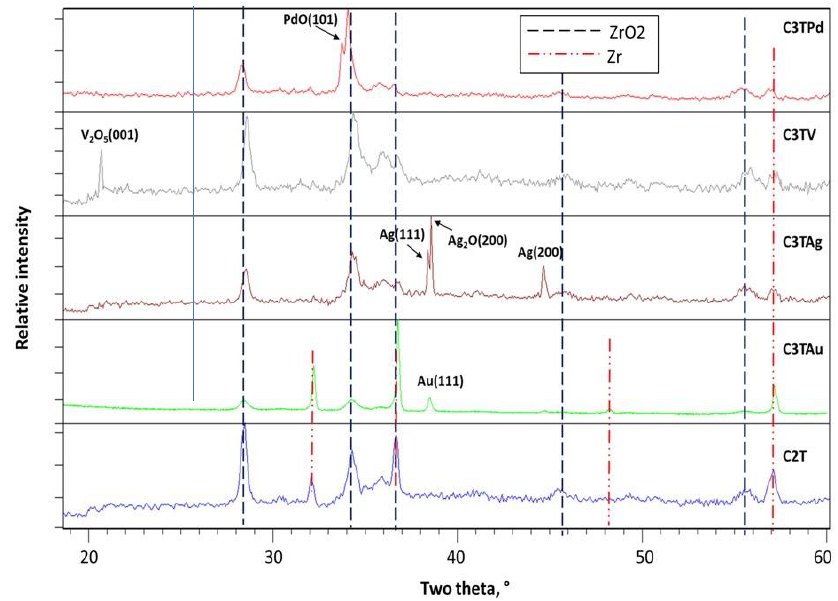
Figure 4. XRD analysis of the samples after the C2T and the C3T process, samples treated at temperature 600 °C for 10 h.